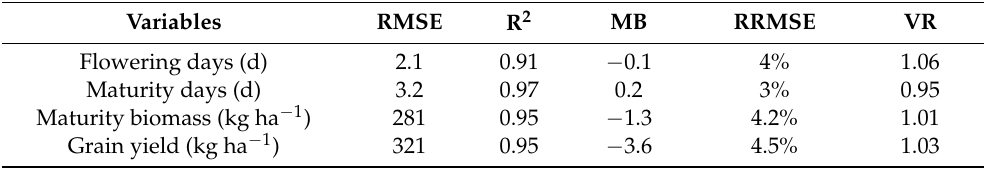
Figure 1. Four sites (Shenxian: SX; Yanzhou: YZ; Feixian: FX; Weifang: WF) located in Shandong province used for simulations in this study. Table 2. Verification statistics of APSIM-Wheat simulations. Data shown are mean observed and simulated values in 2016–2017 and